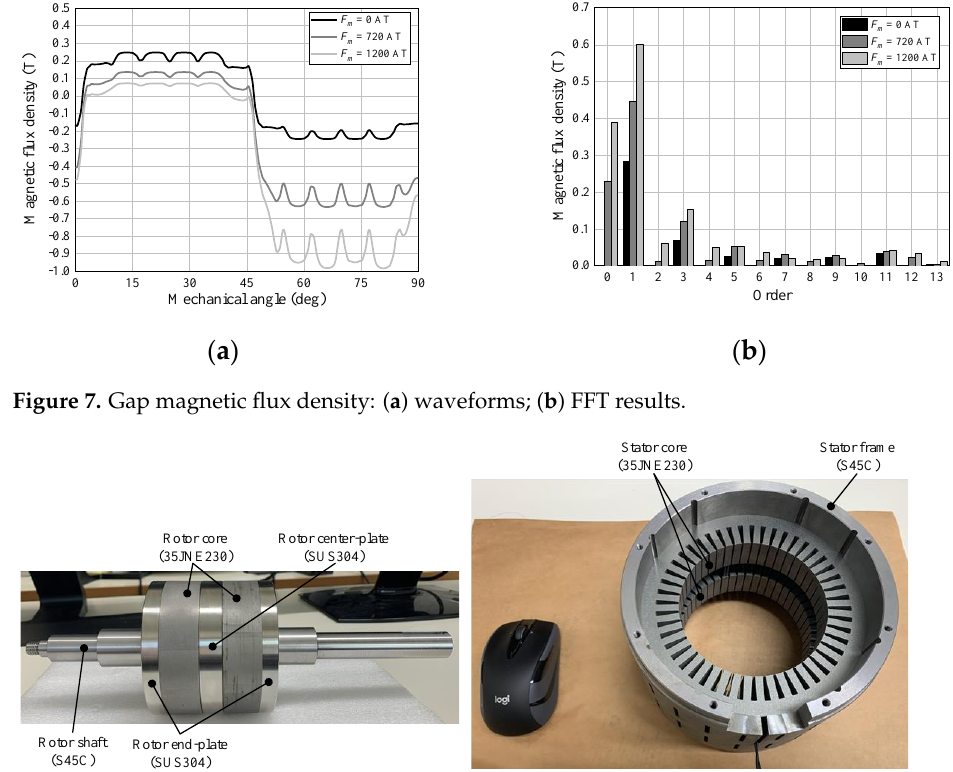
Figure 7. Gap magnetic flux density: ( a ) waveforms; ( b ) FFT results.